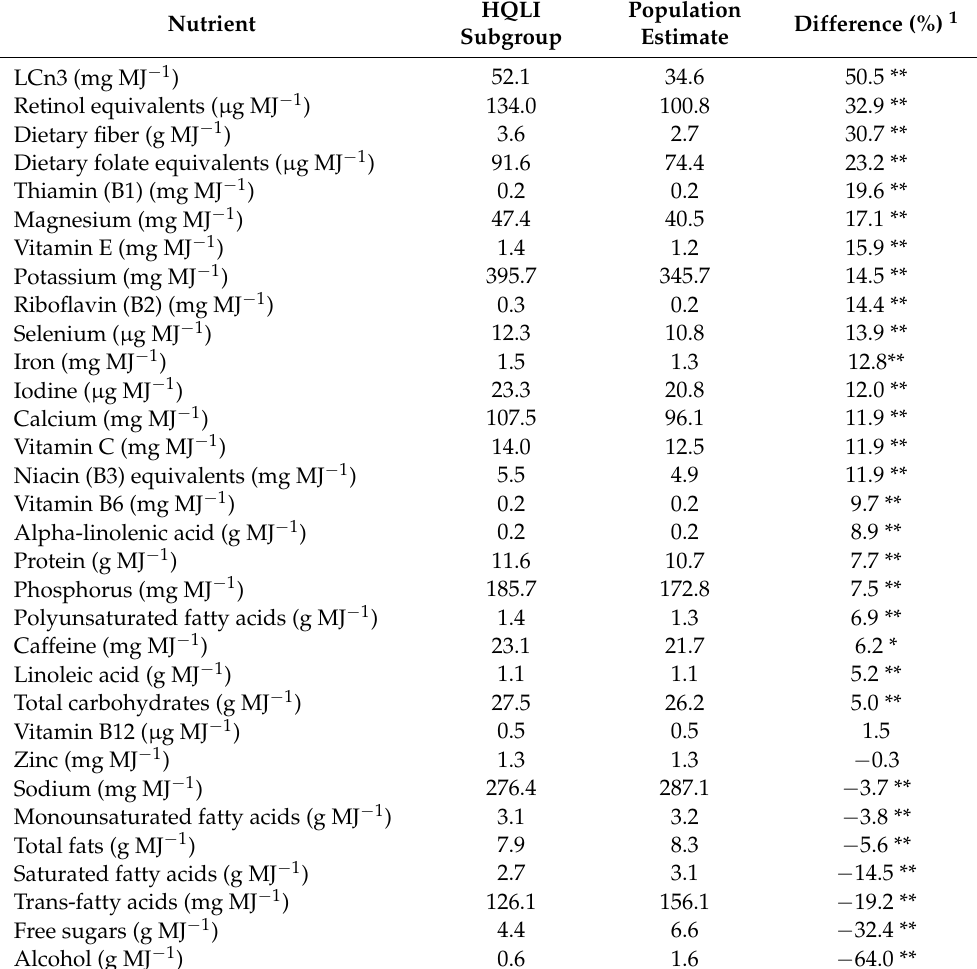
Table 2. Nutrient density of the higher diet quality/lower environmental impact (HQLI) subgroup ( n = 1700) compared to the population estimate ( n = 9341). HQLI Nutrient Subgroup